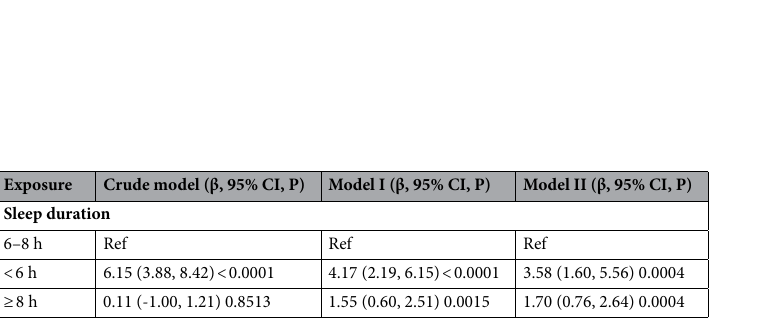
Table 3. Relationship between sleep duration and SBP in different models. Crude model adjust for: None; Model I adjust for: Gender; Age; Race; Model II adjust for: Gender; Age; Race; alcohol; Albumin; Creatinine; Hemoglobin; diabetes; hypertension; snort or stop breathing; smoke; TC; BMI; AST; HDL. CI confidence interval, Ref reference, TC total cholesterol, BMI body mass index, AST aspertate aminotransferase, HDL high- density lipoprotein, SBP systolic blood